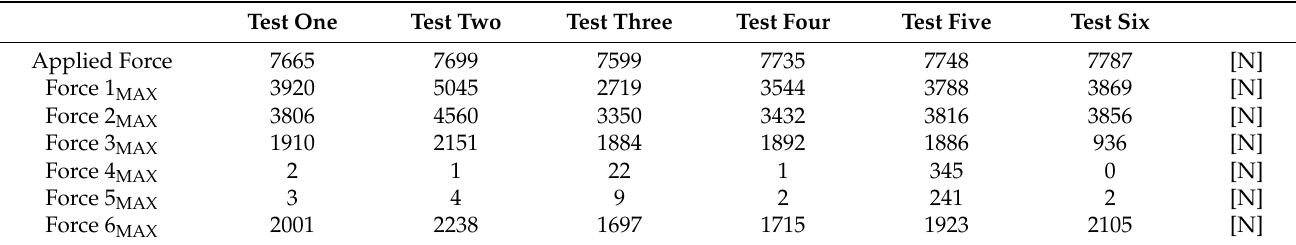
Table 1. Complete results of the maximum forces during